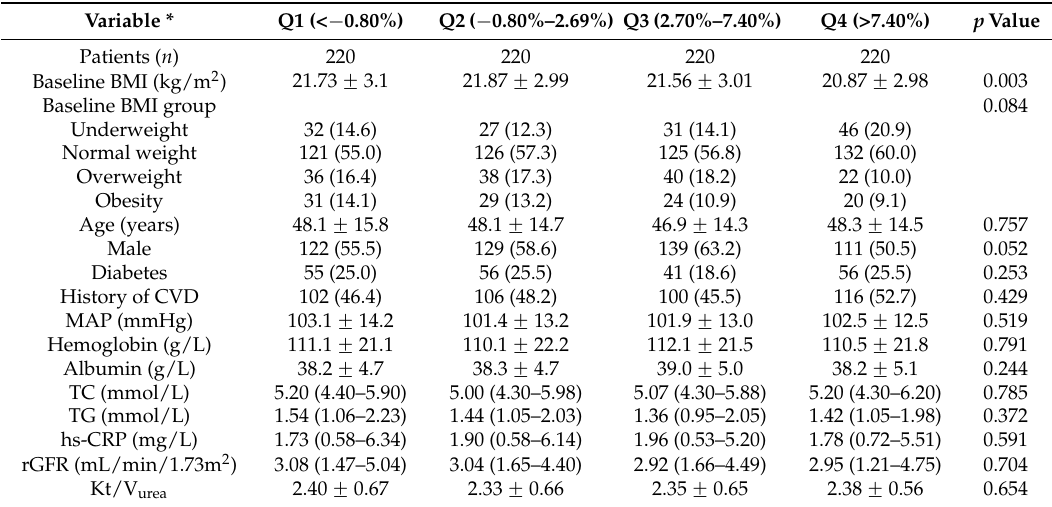
Table 3. Baseline characteristics of the study population by BMI change